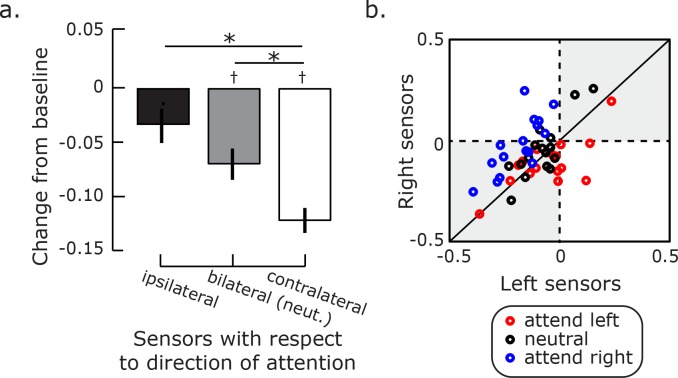
Effects of focused and distributed attention on posterior alpha.a). Mean power change during the attention delay from baseline was computed for posterior sensors ipsilateral or contralateral to the cued visual field (left and right bars), and separately for bilateral sensors following the uninformative cue (middle bar) when attention is presumably distributed across both visual fields. Error bars represent sem. The * symbol indicates a significant difference in alpha power change between the conditions, while the † symbol indicates that the alpha power change was different from the pretrial baseline. b). Scatter plot showing alpha power change from baseline for each trial type, where x and y-axes represent averaged power change extracted from the left and right posterior sensor groups. Each dot represents one subject. Note how the blue and red dots mostly lie above and below, respectively, the unity line highlighting the lateralization of alpha power changes.